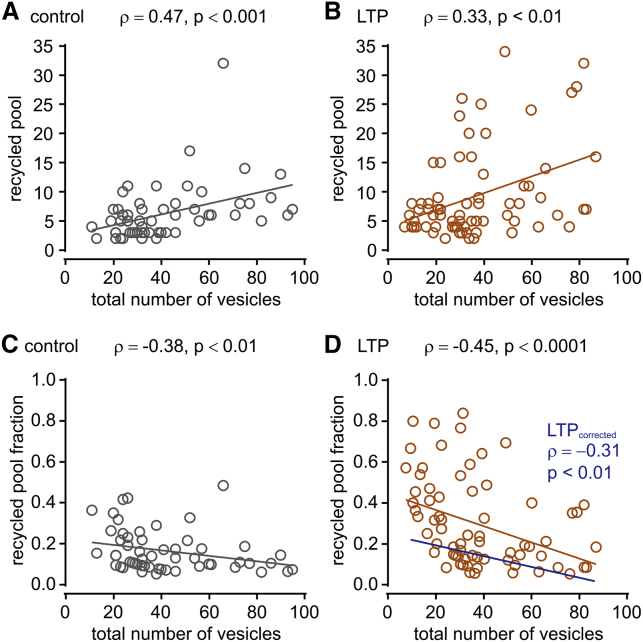
Pool Size Relationships in Control and LTPFor all plots, numbers refer to Spearman’s correlation (ρ) and p values, respectively.(A and B) Scatterplot of recycled pool size versus total number of vesicles for control (A) (n = 56 synapses) and LTP (B) (n = 72 synapses) with linear fits.(C and D) Scatterplot of recycled pool fraction versus all vesicles for control (C) (n = 56 synapses) and LTP (D) (n = 72 synapses) with linear fits. Blue line (LTPcorrected) in (D) shows fit after correcting for the expected pool size-pool fraction relationship observed in controls.